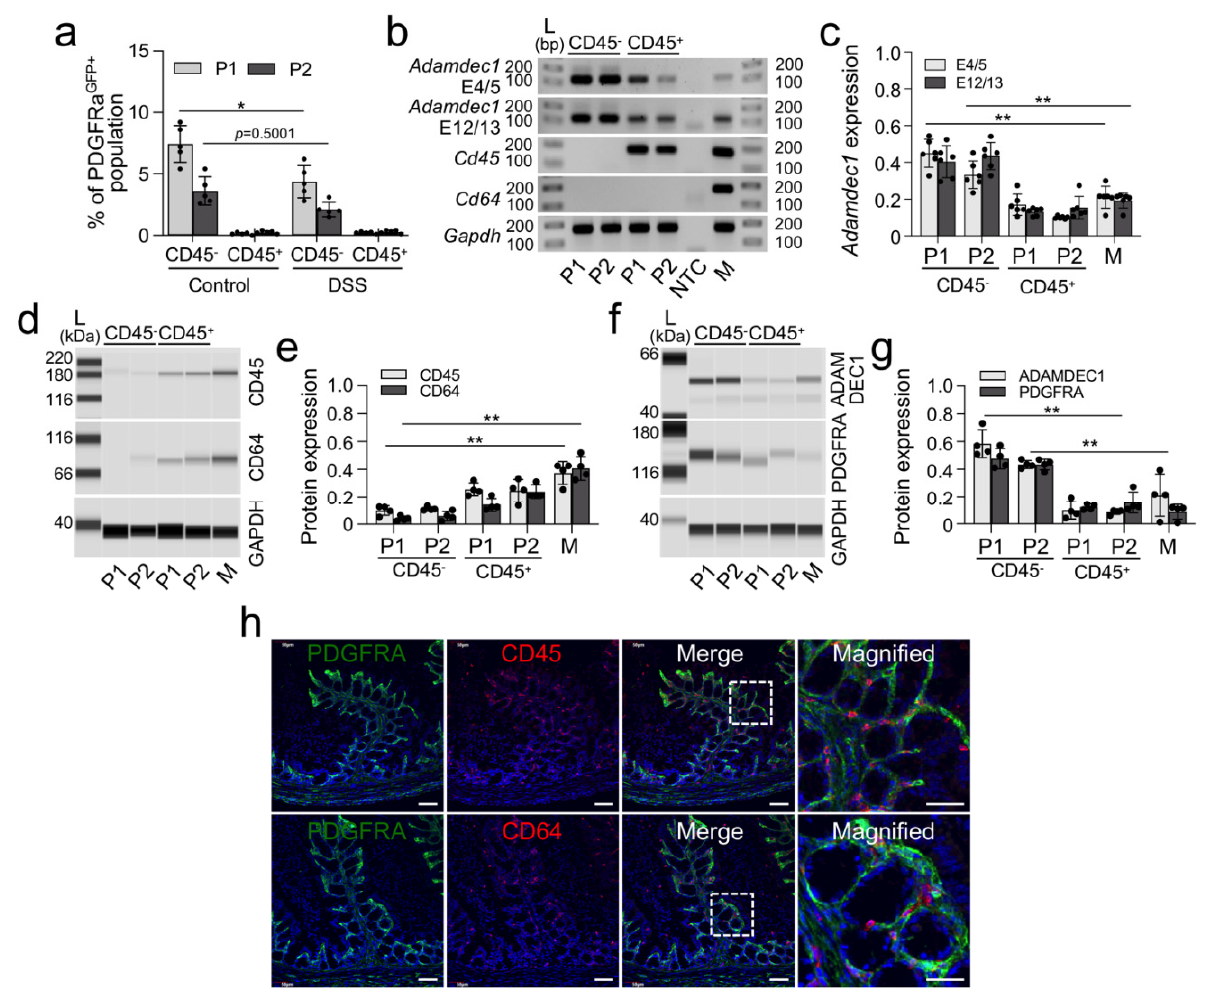
Figure 4. Predominant expression of Adamdec1 in mucosal CD45 − PDGFR α + cells. ( a ) PDGFR α + ( Pdgfra-eGFP + ) populations (P1 and P2) in CD45 − and CD45 + cells identified by flow cytometry at 6 days post DSS treatment (DSS 6D) and control colonic mucosa. Percentage of PDGFR α + cell populations P1 and P2 in DSS 6D and control ( n = 5). * p < 0.05, versus control groups ( b ) Expression of Adamdec1 in isolated P1 and P2 of colonic mucosal CD45 − and CD45 + cells and CD45 + CD64 + CD14 + (macrophages; M) cells at 6 days post DSS treatment colonic mucosa, examined by RT-PCR with primer sets for Adamdec1, Cd45 and Cd64 . Gapdh was used as a loading control. ( c ) Quantitative analysis of Adamdec1 expression in P α C (P1 and P2) of CD45 − cells and CD45 + cells ( n = 5) isolated from DSS-induced colitis colonic mucosa measured by qPCR. ( d ) Expression of CD45 and CD64 protein expression in isolated P1 and P2 of colonic mucosal CD45 − and CD45 + cells and M cells isolated from DSS-induced colitis colonic mucosa. ( e ) Quantification of CD45 and CD64 in (d) normalized by GAPDH ( n = 4). ( f ) Expression of ADAMDEC1 protein expression in isolated P1 and P2 of colonic mucosal CD45 − and CD45 + cells and M cells from DSS-induced colitis colonic mucosa. ( g ) Quantification of ADAMDEC1 in (f) normalized by GAPDH ( n = 4). ( h ) Most PDGFR α + cells do not overlap with CD45 + or CD64 + cells in DSS 6D colonic mucosa. Scale bars are 50 μ m. The dotted white box in the “Merge” image indicates the selected area of zoom for the “Magnified” image of the figure. * p < 0.05 and ** p < 0.01.